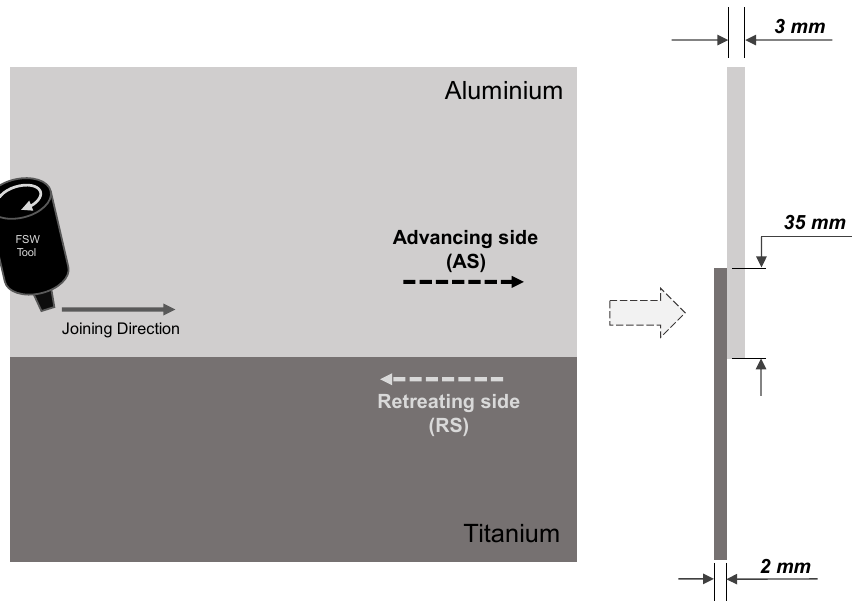
Figure 1. Schematic representation of the joining setup configuration for the AA-Ti joints – aluminum alloy placed on top and advancing side of the joint.